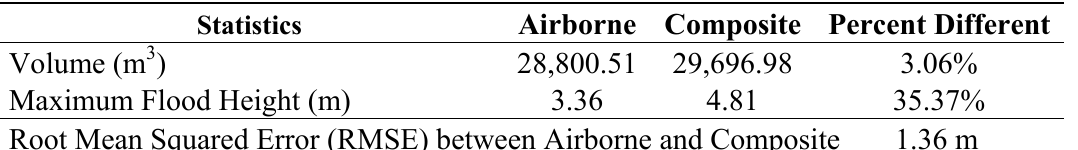
Table 6. Quantitative differences between the depth grids generated using the bare-earth airborne and composite LiDAR